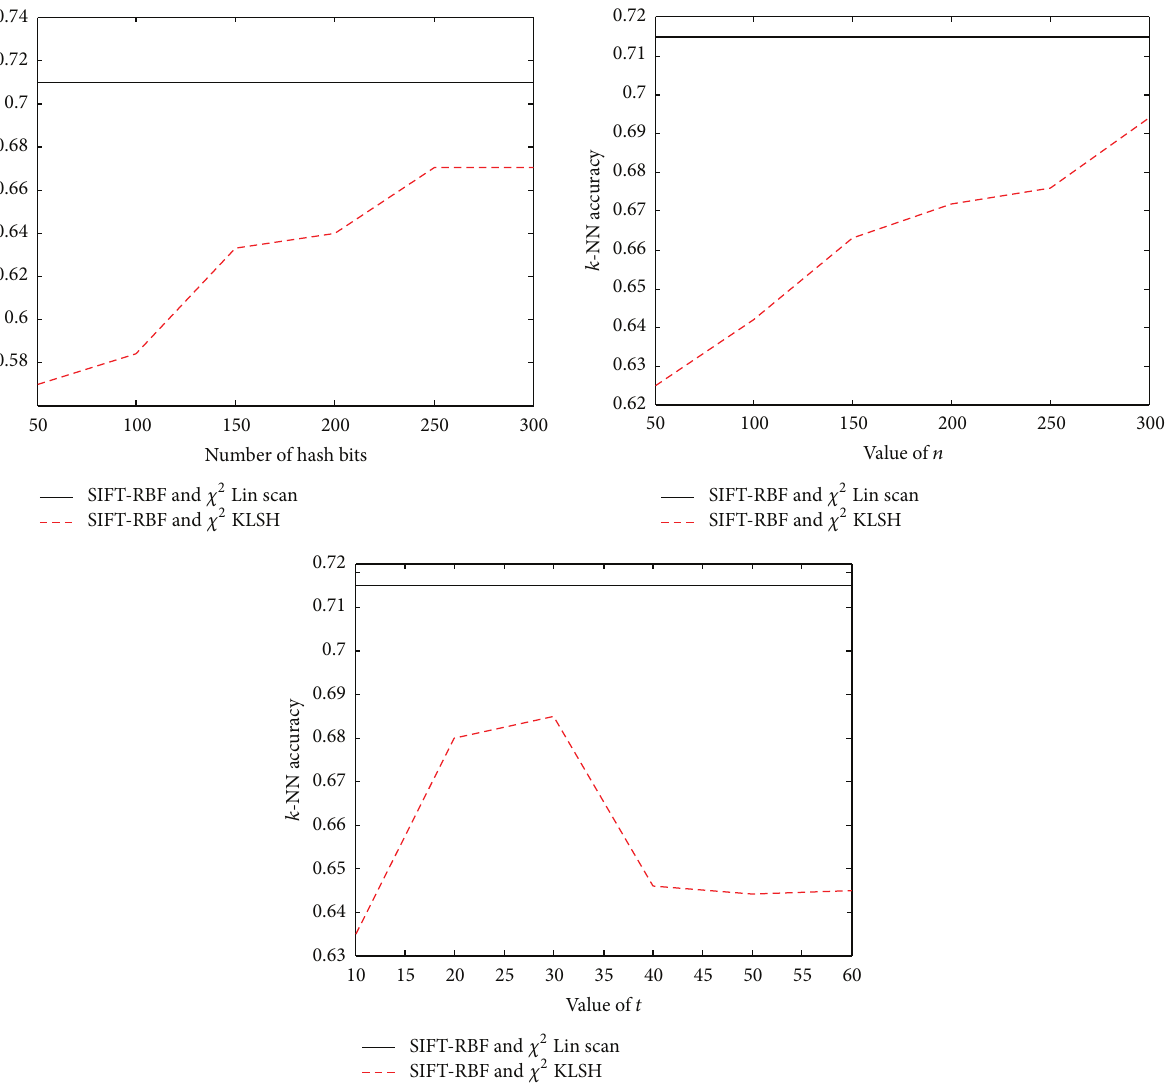
Figure 2: Hashing using a RBF- 𝜒 2 kernel for SIFT based on homogenous kernels 𝜒 2 (𝛾 = 1/2) . We choose 𝑡 = 30 , 𝑛 = 300 , and 𝑏 = 300 in our